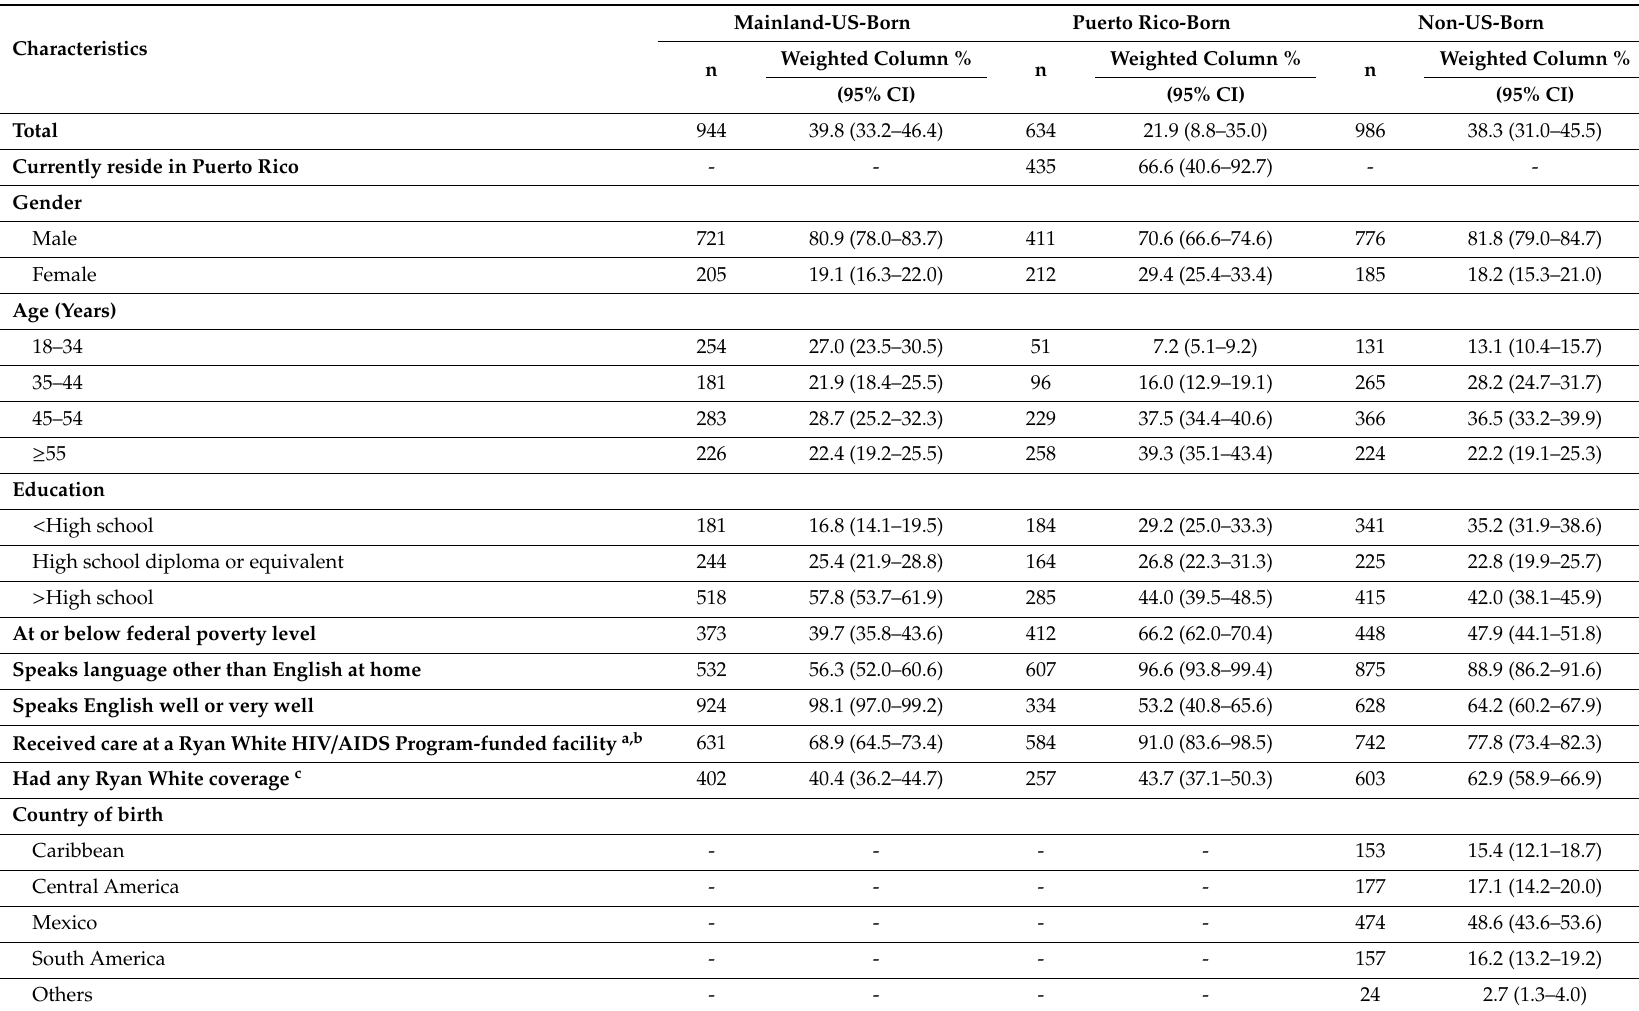
Table 1. Hispanic / Latino adults with diagnosed HIV by place of birth, United States—Medical Monitoring Project, 2015–2018 (n = 2564).